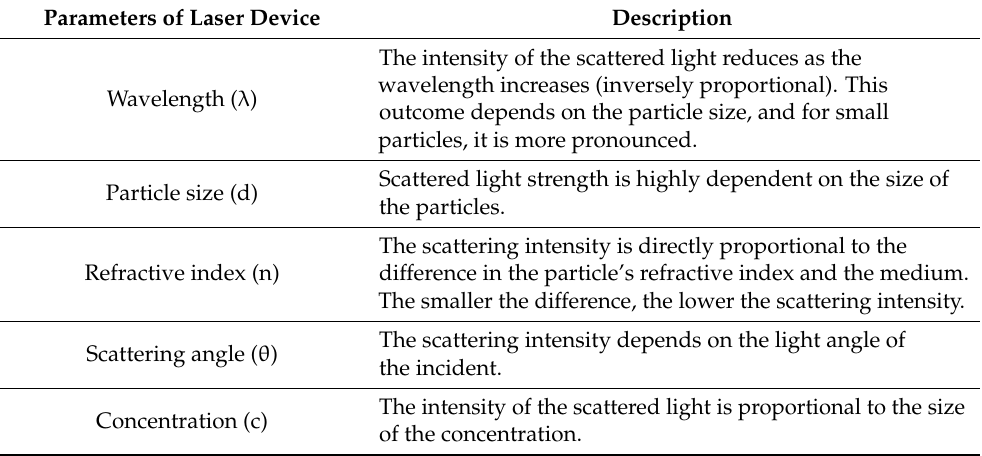
Table 1. Keys of light scattering to enhance diagnosis of